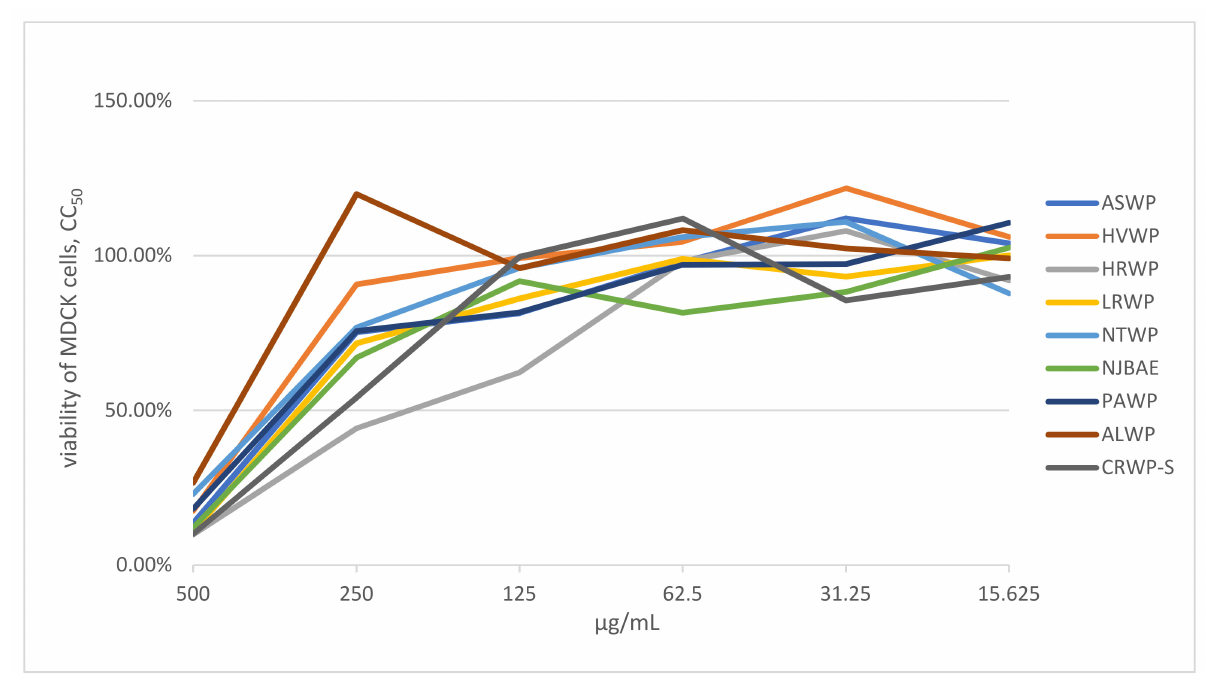
Figure 1. Viability of MDCK cells (%) treated with different concentrations of extracts. Note: CC 50 represents the concentration of medicinal plant, lichen, or mushroom extract required to reduce the number of viable cells by 50% relative to the control wells without test compound, calculated from dose–response data; extract concentrations are expressed in µ